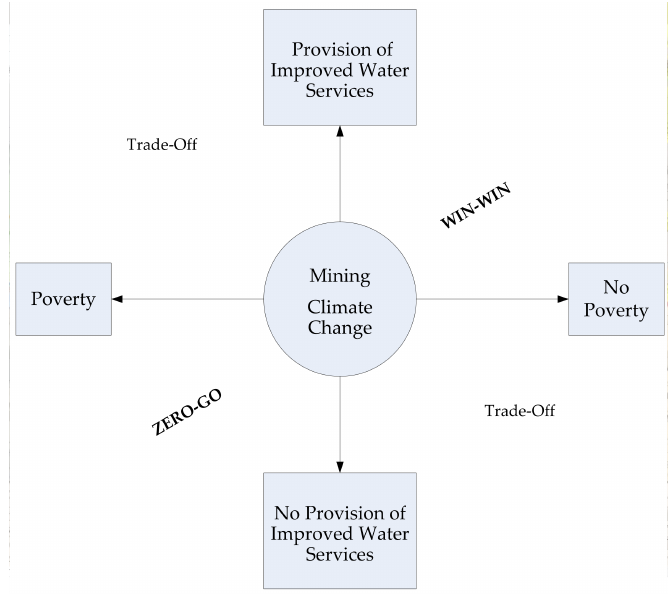
Figure 1. Conceptual framework of the